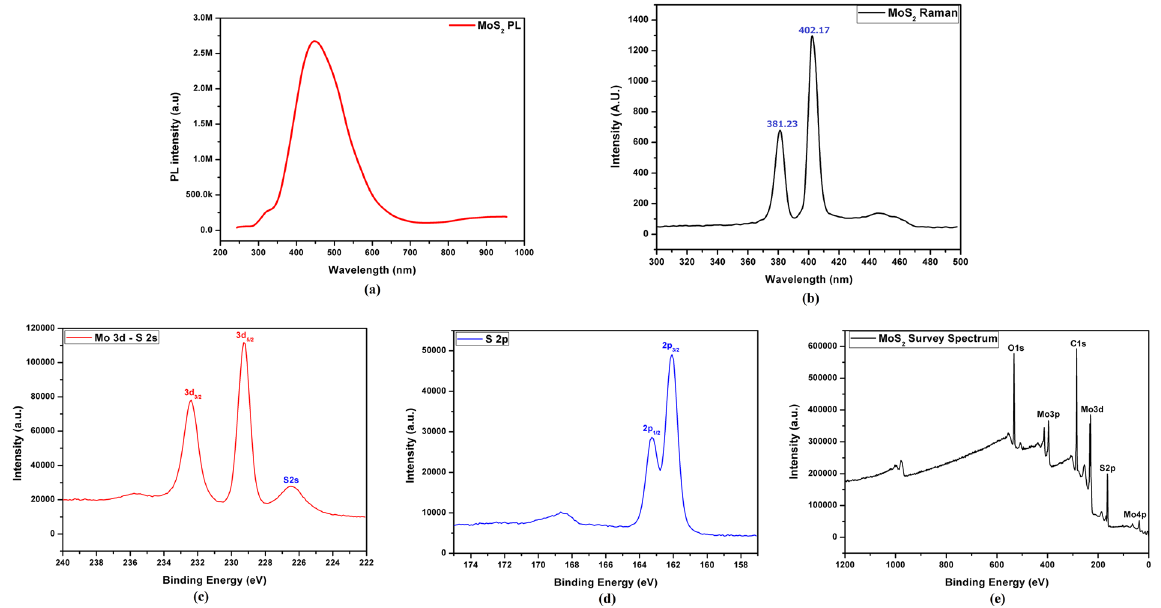
Figure 2. Chemical characterizations including. ( a )PL emission spectrum, ( b ) Raman spectrum, ( c–e ) XPS spectra of MoS 2 active